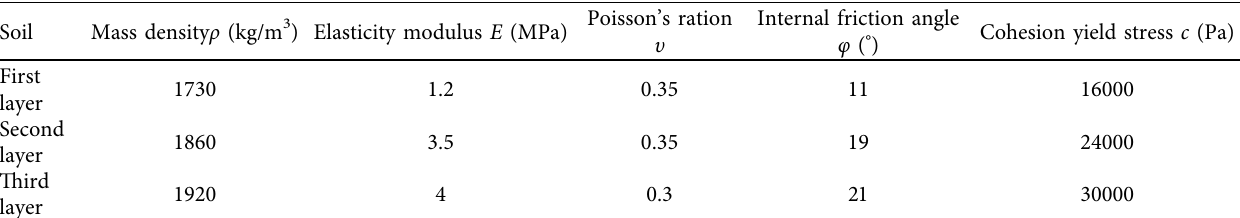
Table 2: Soil parameters of each layer.